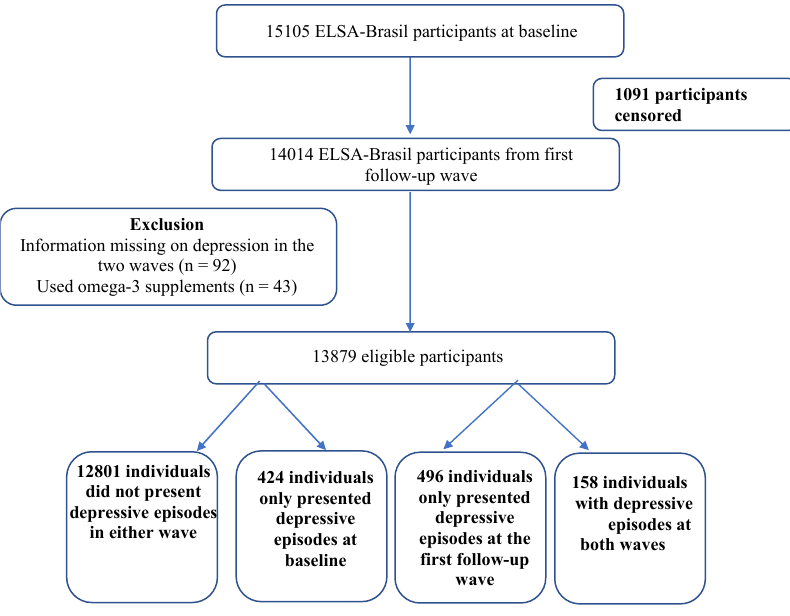
Figure 1. Final study population ( n = 13.879, ELSA-Brasil, 2008–2014).